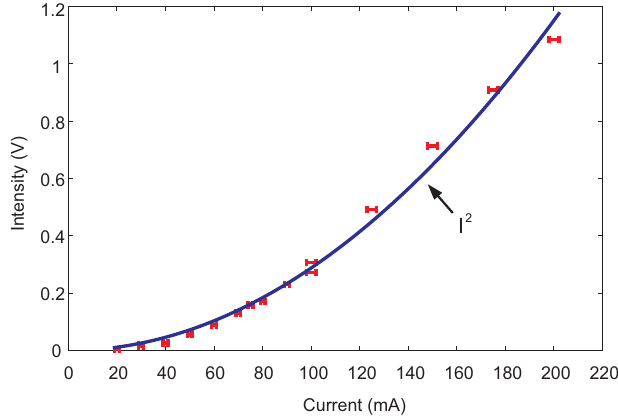
FIG. 3. (Color) Plot of the measured SPR intensity as a function of beam current. A curve proportional to the square of the beam current, I, is also